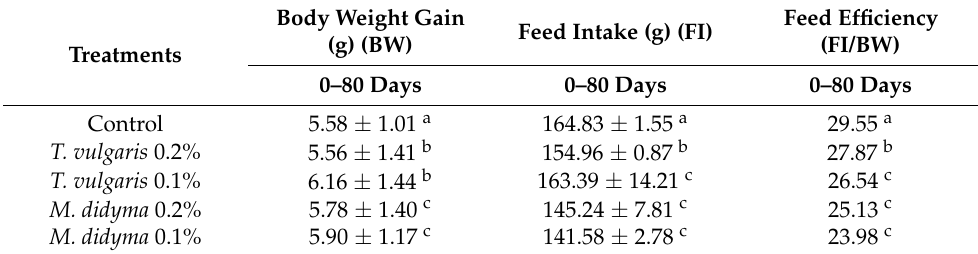
Table 4. Comparison of mean body weight gain (g), feed intake (g), and feed efficiency of the mouse treatments.